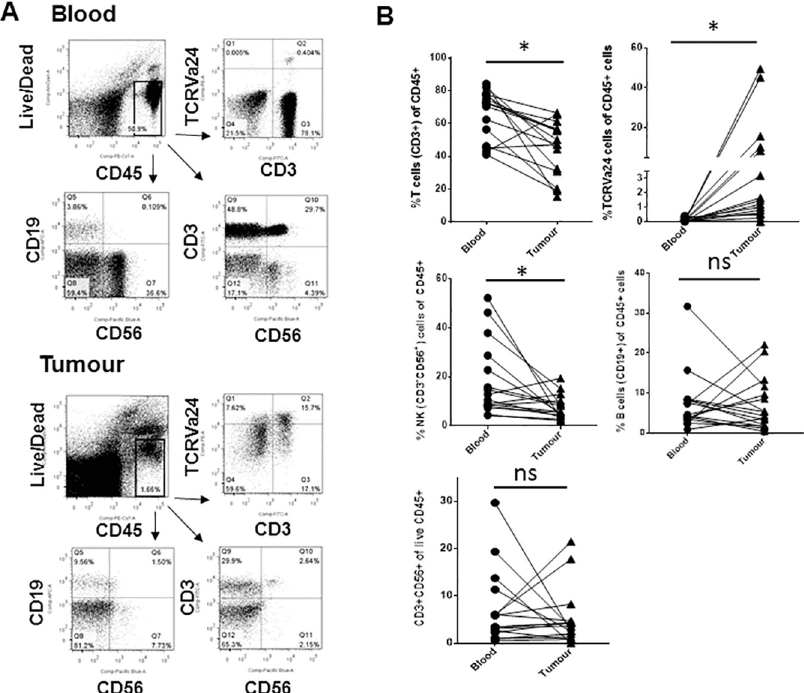
Fig 2. The fraction of T cells, NKT cells and NK cells is significantly different between blood and tumour from patients with perineural SCC. Freshly excisedtumour and matchedbloodsampleswere stainedwith antibodies againstvariousimmunecellmarkers and analysedby flow cytometry. (A) An example of the gatingstrategy usedto analysedifferentimmunecellsubsets withinbloodand tumour. (B) The percentage of CD3 + (T cells), TCRVa24 + (NKT cells), CD3 - CD56 + (NK cells), CD19 + (B cells) and CD3 + CD56 + (activatedT cells/NKT cells) cells amongstliveCD45 + cells was plottedfor both tumour and bloodsamplesfor individual patients. Lines connectthe matchedbloodand tumour samplefrom each individualpatient. * indicatesp < 0.05